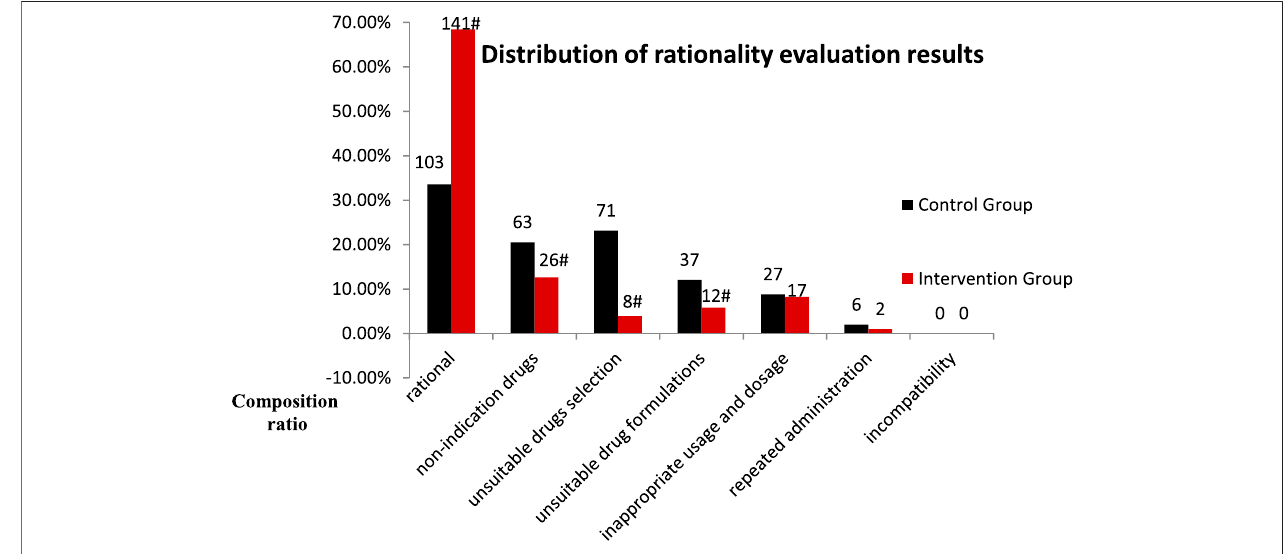
FIGURE 5 | Distribution of rationality evaluation results for PPI use in the control and intervention groups (Compared with the control group. # p < 0.05).